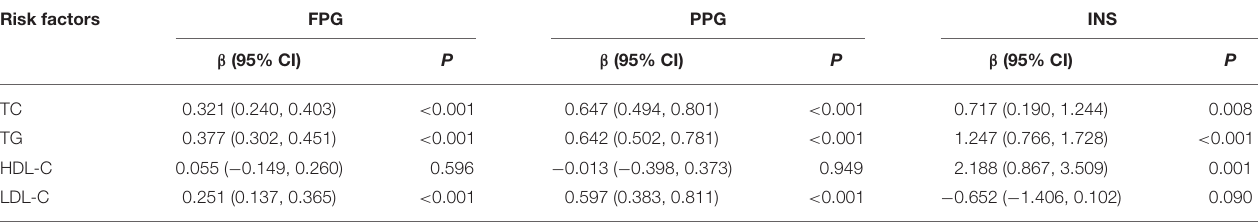
TABLE 3 | The association of different glucose level with measurements of lipids in the univariate analysis. Risk factors